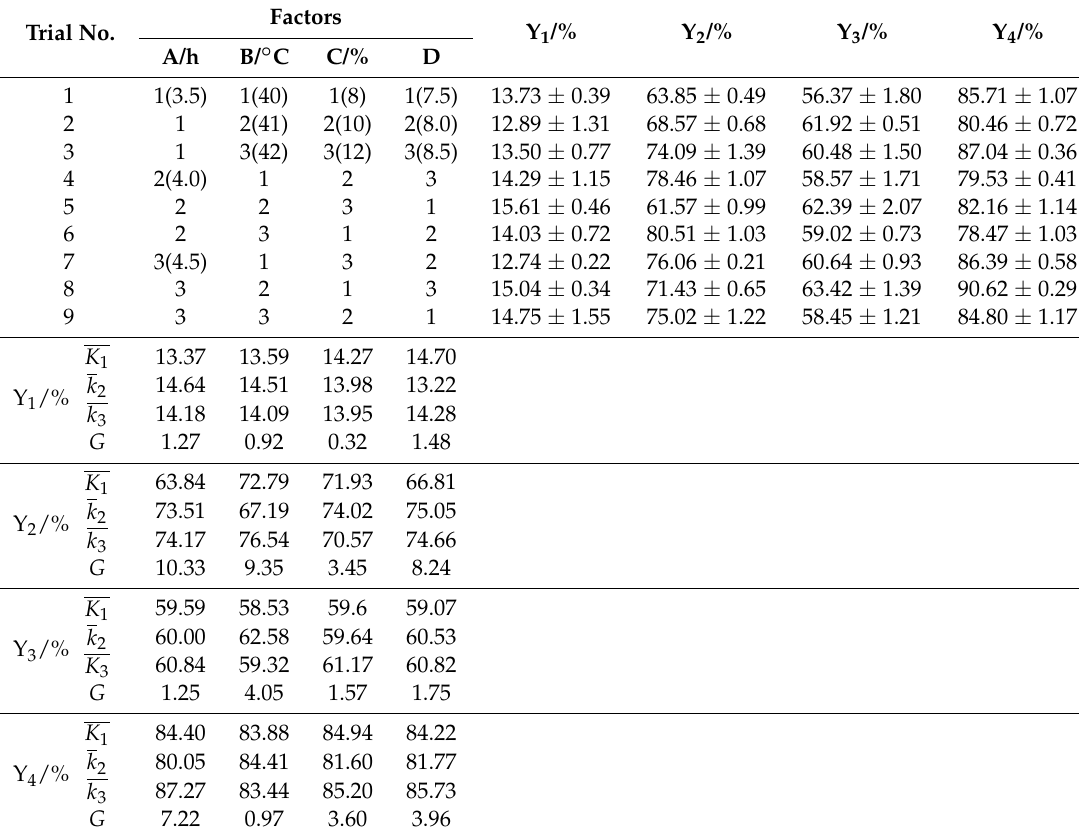
Table 1. Analysis of orthogonal experiments for the effects of time (A), temperature (B), E / S (C), and initial pH (D) on CEPs hydrolysis. DH, ACE-inhibitory rate, DPPH radical scavenging rate, and hydroxyl radical scavenging rate were represented by Y 1 (%), Y 2 (%), Y 3 (%), and Y 4 (%), respectively. Trial